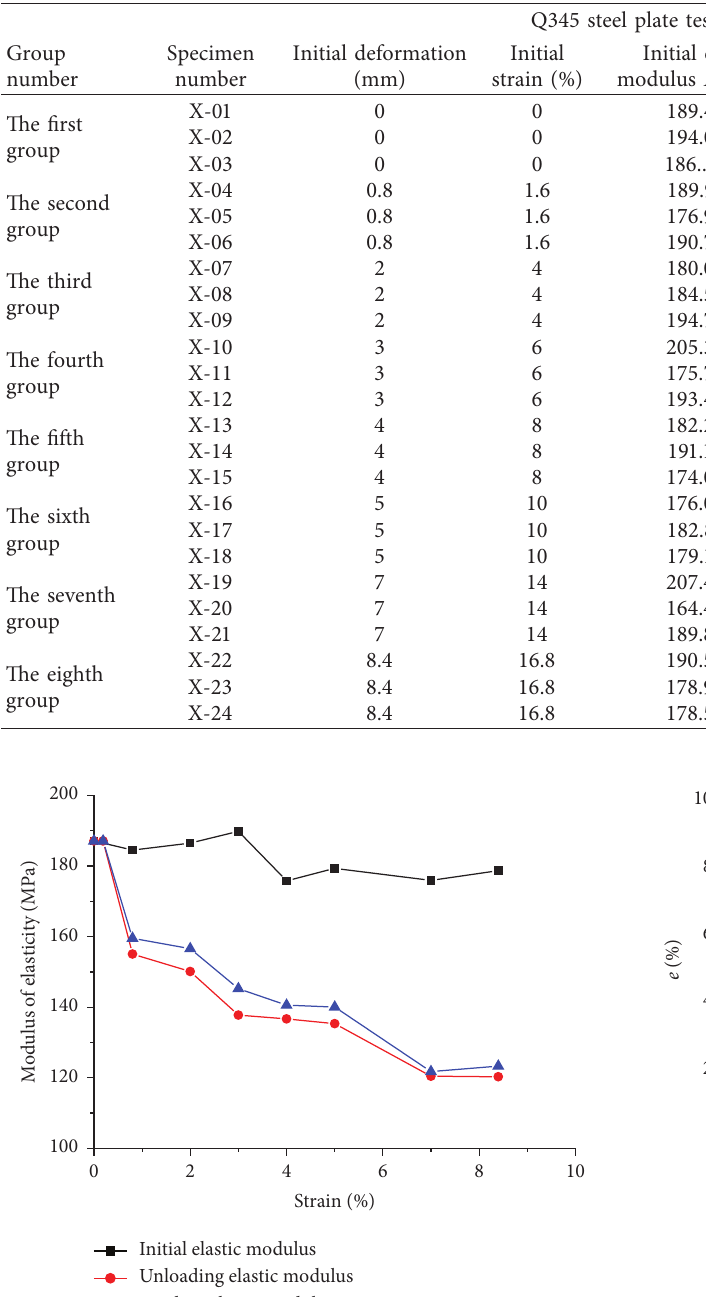
Figure 5: Comparison of elastic